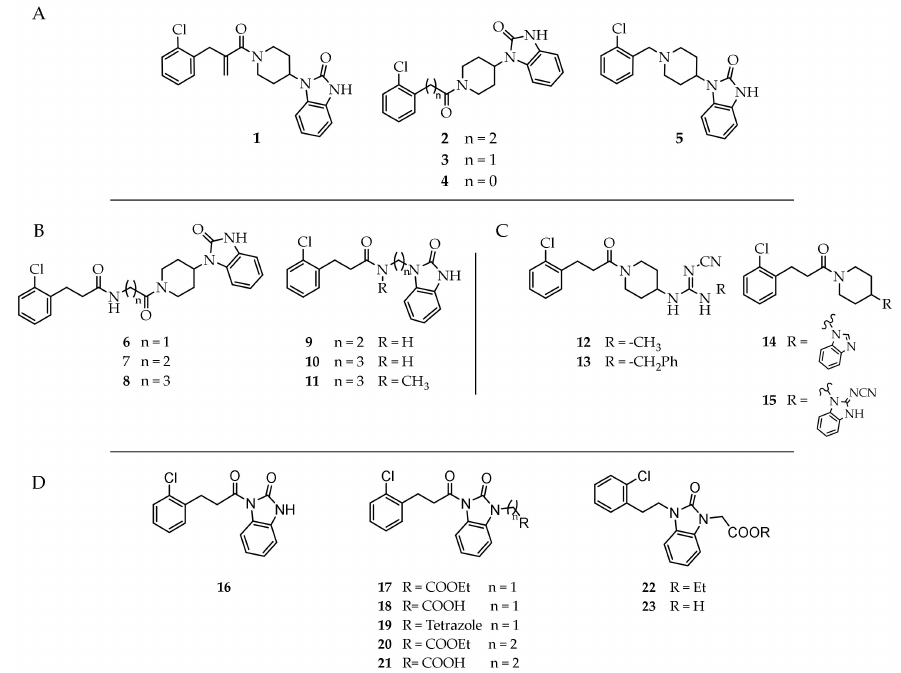
Figure 1. Structures of previously developed NLRP3 inhibitors INF4E, INF39, INF58 and newly designed model compounds 1 and 2 .